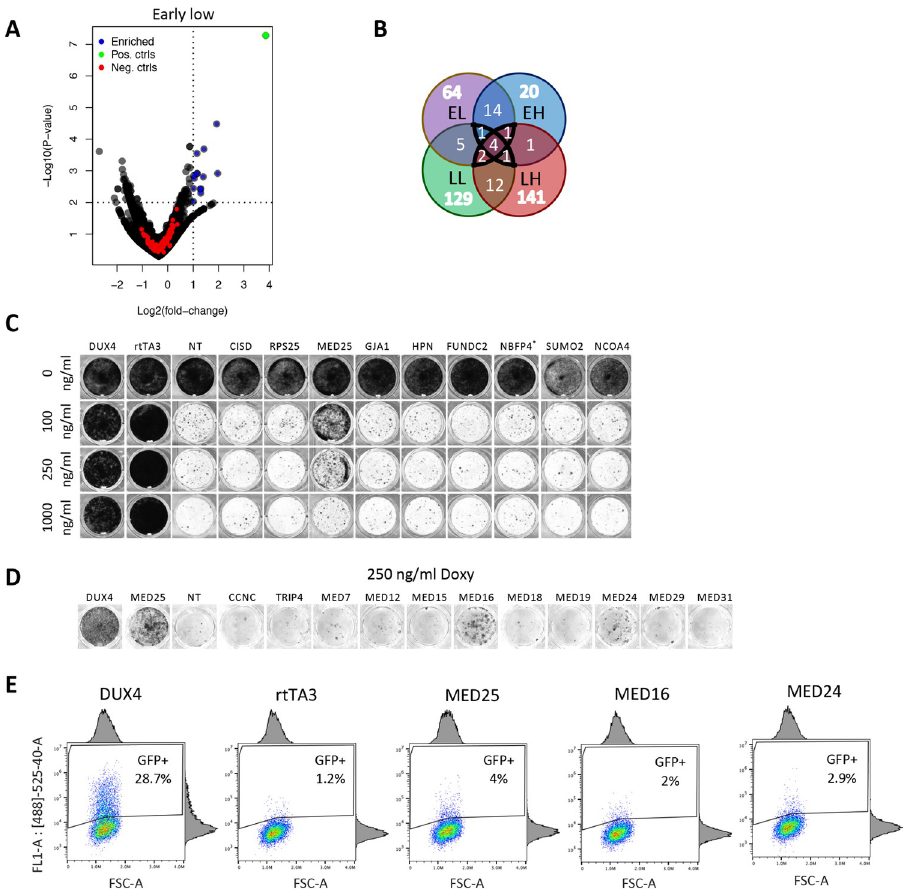
Fig 4. Filtered CRISPR screen data and validation of potential hits. (A) Adjusted volcano plot of screen data with low doxycycline (250ng/ml)/early harvest (24h after doxycycline removal, see Fig 3B) showing the enrichment of sets of guides targeting genes not located on chromosome 5q or chromosome 19p. Blue points represent guide sets that are significantly enriched (P-value � 0.01), Log2(fold change) � 1), the green point is the positive control (DUX4), red points represent the non-target control guides. (B) Venn diagram showing the overlap of filtered hits between the four screens (EL: Early harvest-low Doxy, LL: Late harvest-Low doxy, EH: Early harvest-high Doxy, LH: Late harvest-High doxy), see also Fig 3B. (C) Viability staining showing surviving DIE cells containing single knockouts of potentials hits, identified in the CRISPR screen. Knockouts of individual genes were generated by transfection of sgRNA; 6 days later, cells were left untreated or treated with 3 different concentrations of doxycycline (100, 250 and 1000ng/ml) for and incubated for an additional 48–96 hours prior to visualizing surviving cells. Data are representative of at least three independent experiments. (D) Viability staining showing the surviving DIE-ieGFP-Cas9 cells (DIE cells expressing Cas9 constitutively and contain doxycycline-inducible eGFP) with single knockouts of mediator complex subunits. Knockouts of individual genes were generated by transfection of sgRNA; 6 days later cells were treated for doxycycline (250ng/ml) for 24h and incubated for an additional 48–96 hours prior to visualizing surviving cells. Data are representative of at least three independent experiments. (E) FACS data showing GFP-positive cells in surviving populations of DIE-ieGFP-Cas9 (expressing constitutive Cas9 and doxycycline-inducible GFP). cells containing single knockouts as indicated. Knockouts of individual genes were generated by transfection of sgRNA; 6 days later, cells were treated with doxycycline (250ng/ml) for 24h prior to FACS analysis. DIE-ieGFP-Cas9 cells comprised of 42% of eGFP-positive cells after DUX4 knockout. rtTA, MED25, MED24 and MED16 knockouts displayed a lower percentage of eGFP-expressing cells, comprising between 1.2–4% of eGFP-expressing cells. Data are representative of at least three independent